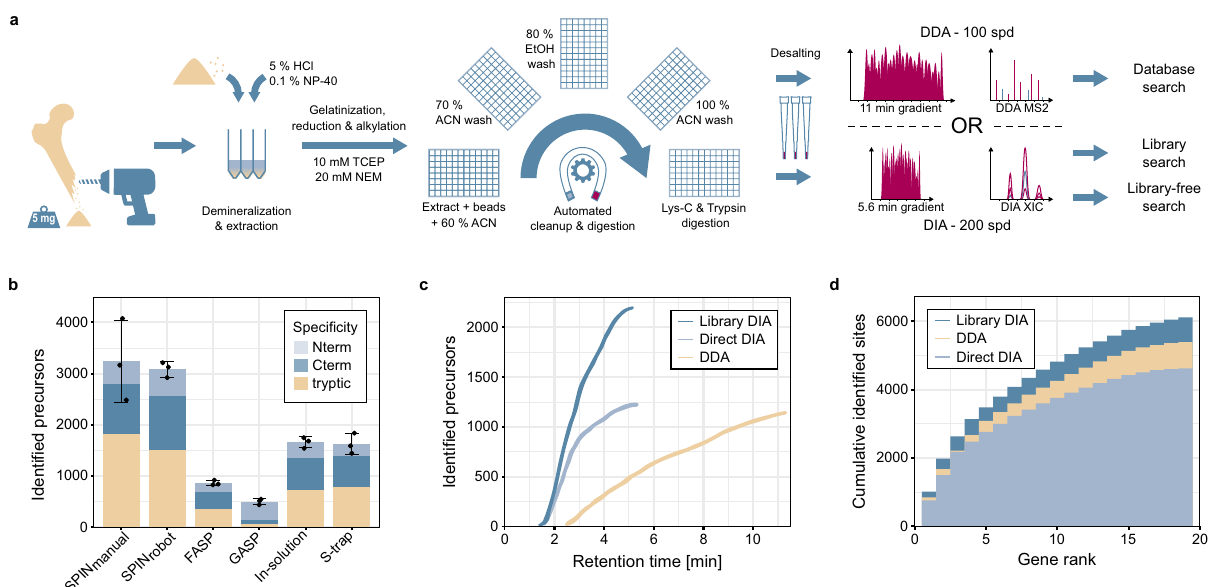
Fig. 1 High-throughput bone proteome analysis work fl ow and benchmark. a Sample preparation and data acquisition. Proteins were obtained from bone chips or powder by simultaneous demineralization and extraction. Cleanup by Protein Aggregation Capture and digestion can be automated by a magnetic bead-handling robot. Peptides were rapidly separated and analyzed by tandem mass spectrometry with a throughput of 100 samples per day (spd) in data- dependent or 200 spd in data-independent acquisition mode. b Performance of the “ Species by Proteome INvestigation ” (SPIN) sample preparation protocol executed manually (SPIN manual ) or by robot (SPIN robot ), compared to other common sample preparation techniques. Methods were compared by analyzing Pleistocene mammoth bone powder from the same batch in n = 3 technical replicate experiments with a 60 spd gradient and data-dependent acquisition. Bars indicate mean precursor identi fi cations obtained with each method separated by enzymatic cleavage speci fi city shown by color with sand color for tryptic, dark blue for semi-tryptic with non-tryptic C-terminus and light blue for semi-tryptic with non-tryptic N-terminus. Error bars are centered at the total number of precursor identi fi cations and indicate standard deviation. c Comparison of precursor identi fi cations accumulated over retention time between the fast 100 spd DDA method analyzed by conventional database searching (sand color) and the rapid 200 spd DIA method analyzed with a library-based (dark blue) vs. library-free (light blue) approach. Peptides were generated by SPIN using a bovine bone and analyzed by LC-MS/MS with the two acquisition methods. d Gene-wise cumulative absolute amino acid coverage based on the precursors identi fi ed in c shown over the top 20 genes ranked by the number of precursors. Color indicates acquisition and peptide identi fi cation method with sand color for DDA, dark blue for library-based DIA, and light blue for library-free